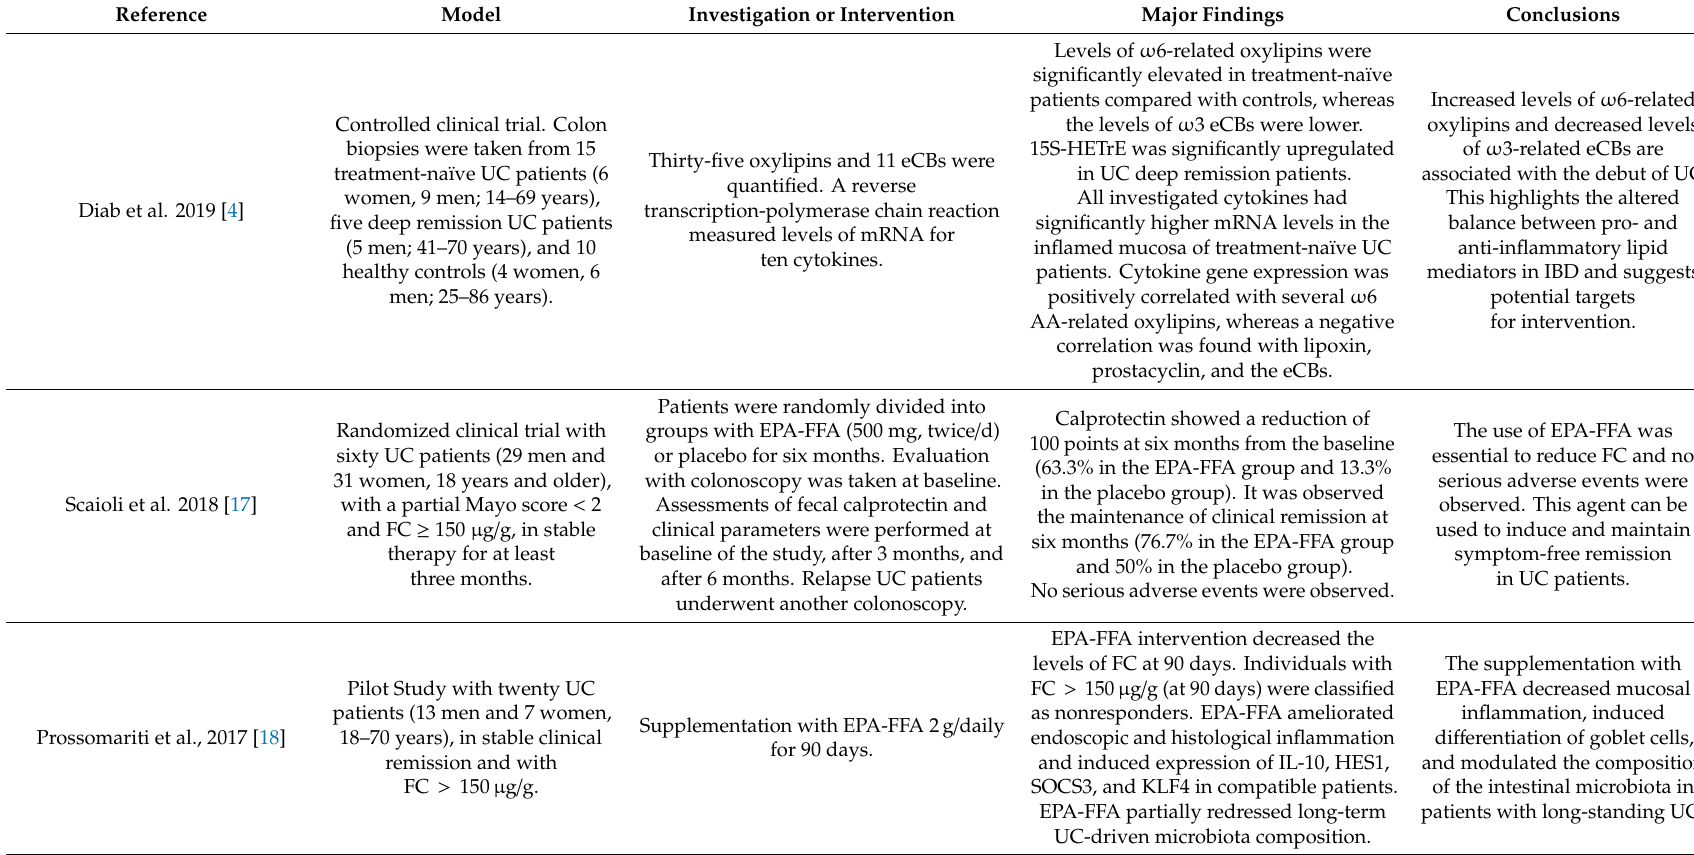
Table 1. Properties of ω 3 fatty acids in the therapeutic approach of inflammatory bowel